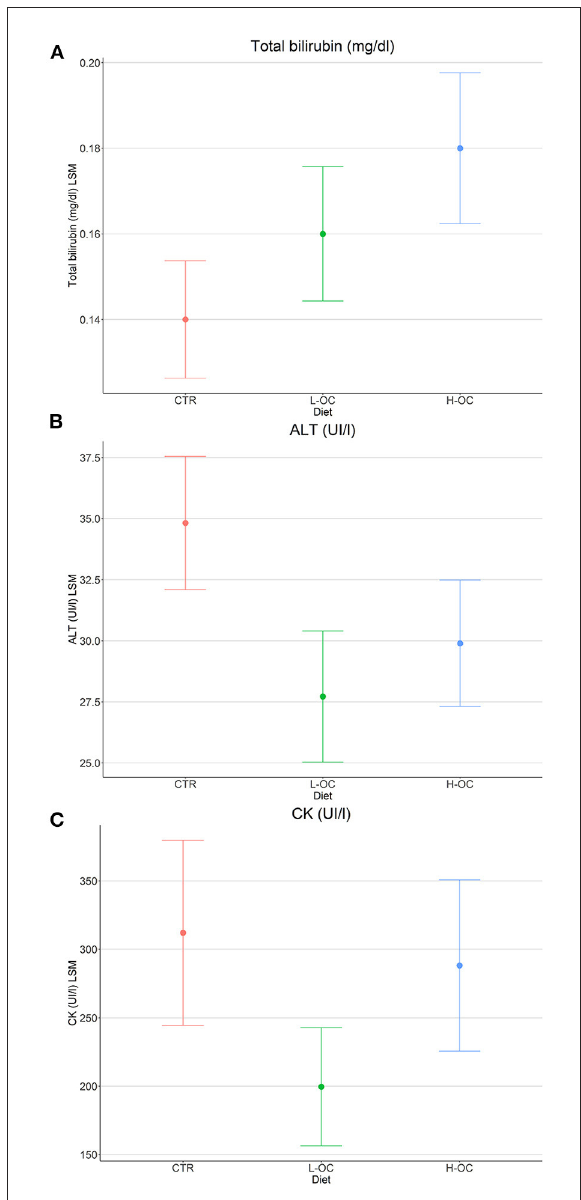
FIGURE1 Significant effect of the diet on total bilirubin (A) , ALT (B) , and creatin kinase [CK, (C) ]. The parameters’ least square mean (LSM) and standard error are represented for all the groups with different olive cake inclusions, namely control (CTR, 0%), Low-olive cake (L-OC, 10%), and High-olive cake (H-OC, 15%) groups.